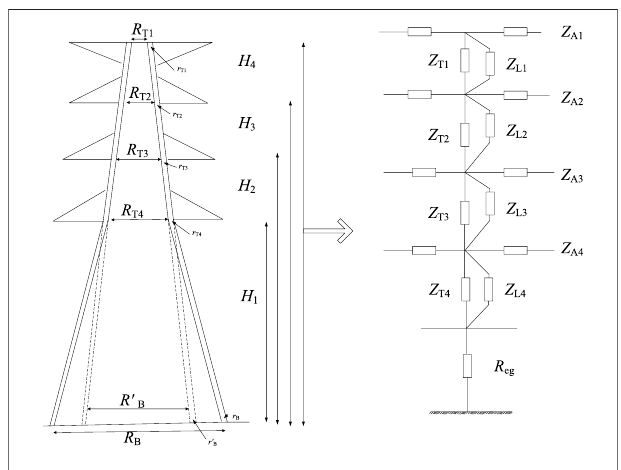
FIGURE 1 | Structure diagram of equivalent